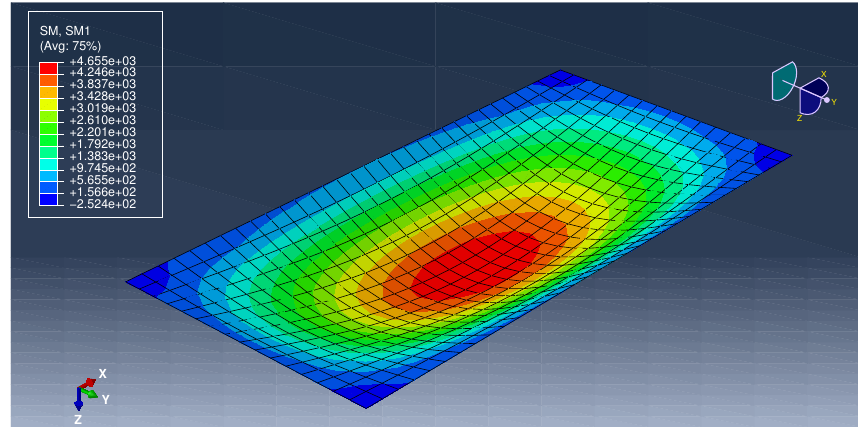
Figure A5. The bending moment M 11 of a simply supported rectangular plate solved using FEM.